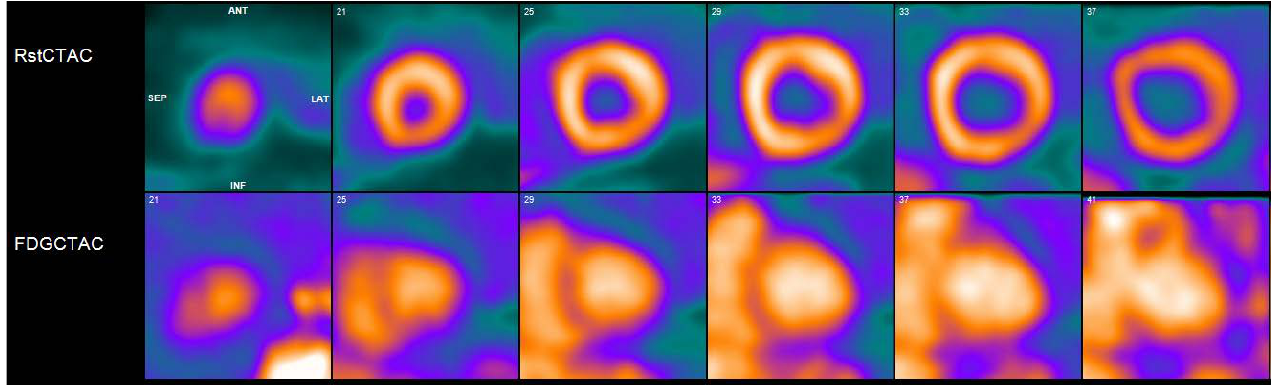
Figure 2. Cardiac positron emission tomography/computed tomography (PET/CT) with 13 N-ammonia (top row) and 18 F-flurodeoxyglycose (FDG) (bottom row) demonstrates normal resting perfusion and adequate myocardial suppression with no evidence of FDG uptake to suggest active inflammatory state.